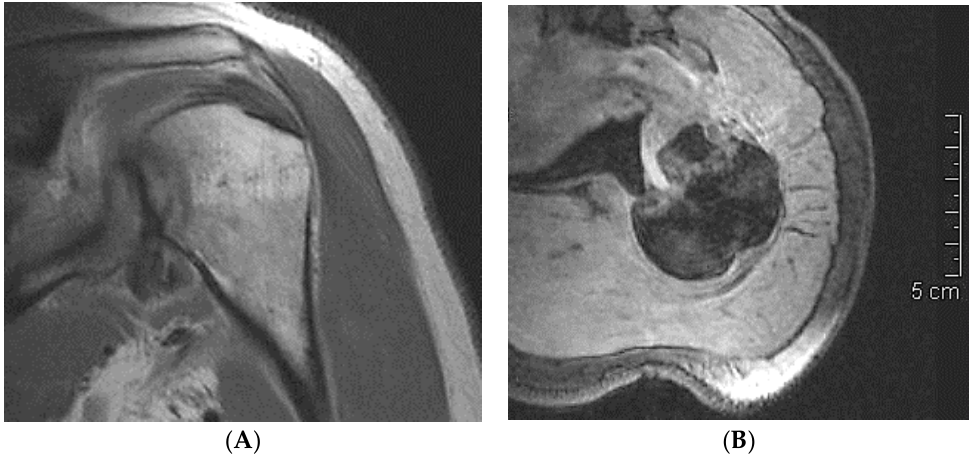
Figure 2. ( A , B ) Preoperational MRI showing the chondral lesion of the humeral